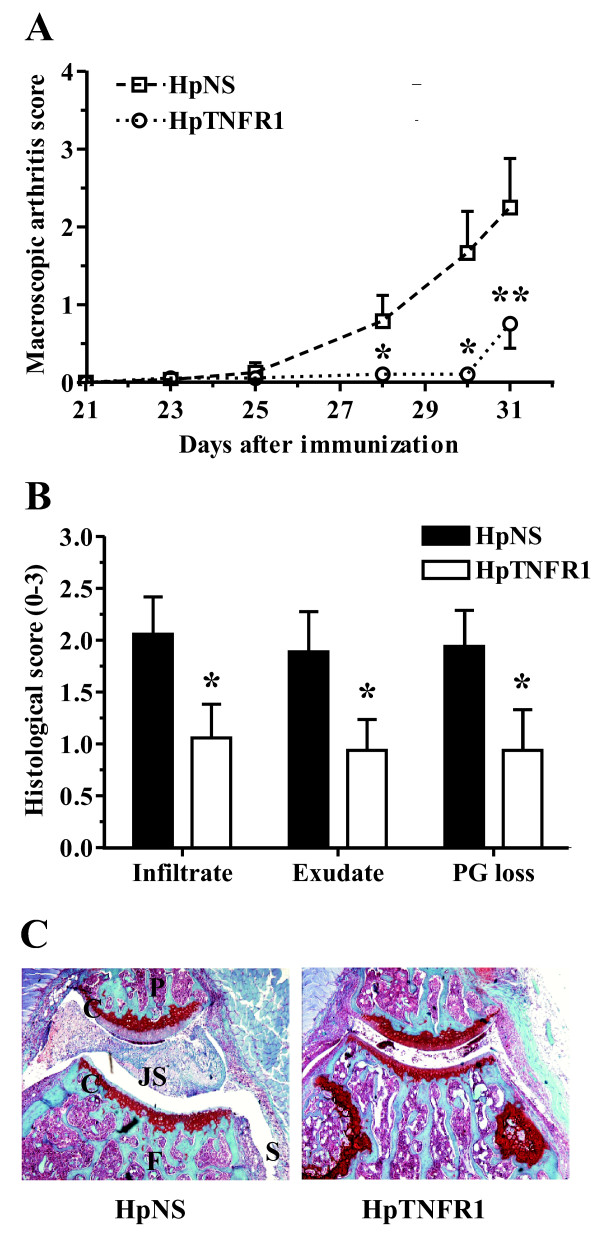
Tumor necrosis factor receptor 1 (TNFR1) silencing in the hepatic and splenic reticuloendothelial system ameliorates collagen-induced arthritis (CIA). One day after collagen booster, CIA-negative mice were injected intravenously with 3 × 108 ffu hairpin construct targeting TNFR1 (HpTNFR1) or hairpin non specific (HpNS). (a) Appearance of arthritis in fore and hind paws was monitored at indicated time points and scored for severity. (b) Histological analysis of inflammation ('infiltrate' and 'exudate') and proteoglycan depletion in patellar and femoral cartilage ('PG loss') from knee joints isolated at day 31. Data are represented as mean ± standard error of the mean (n = 6 mice), and statistical differences were calculated using Mann-Whitney U test. *P < 0.05, **P < 0.005. (c) Representative picture of safranin-O-stained tissue sections of knee joints from mice treated systemically with HpNS or HpTNFR1. Original magnification × 40. C, cartilage; F, femur; JS, joint space; P, patella; S, synovium.